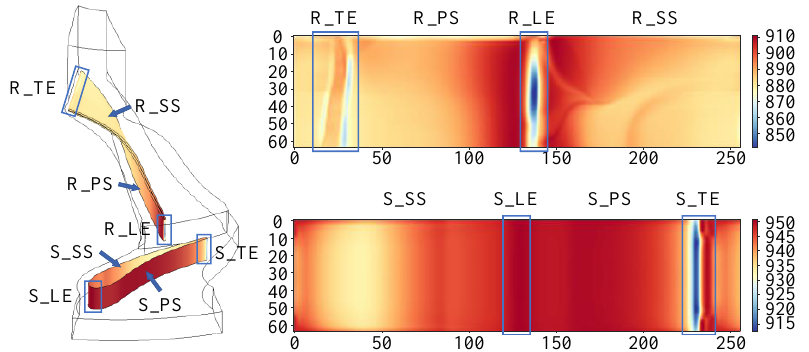
Figure 9. Structure diagram of the field.